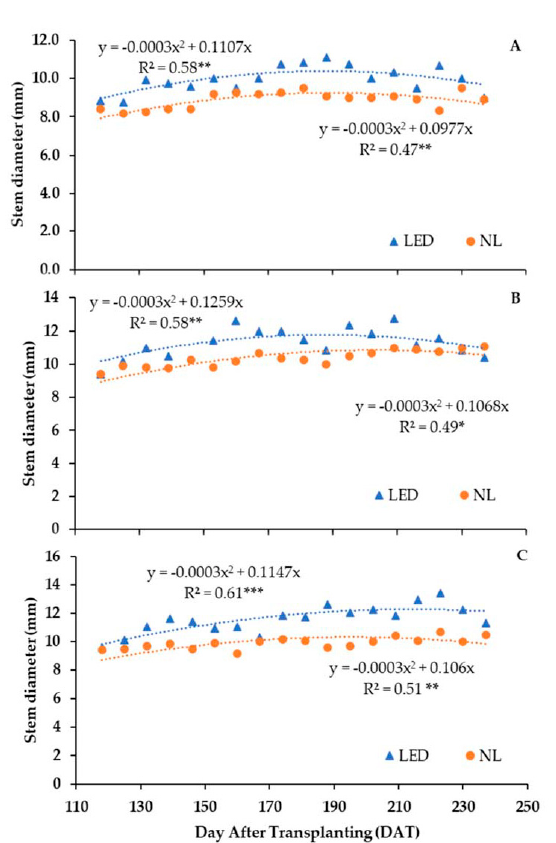
Figure 5. Relationship between stem diameter and day after transplant (DAT). Each symbol represents the mean of six replications for ‘Solarino’ ( A ) and ‘Sorentyno’ ( B ) and of eight replications for ‘Juanita’ ( C ). Di ff erent symbols and colors represent the di ff erent light treatments. Regression equations and R 2 coe ffi cients are presented. ***, ** and * indicate significance at p ≤ 0.001, 0.01 and 0.05,